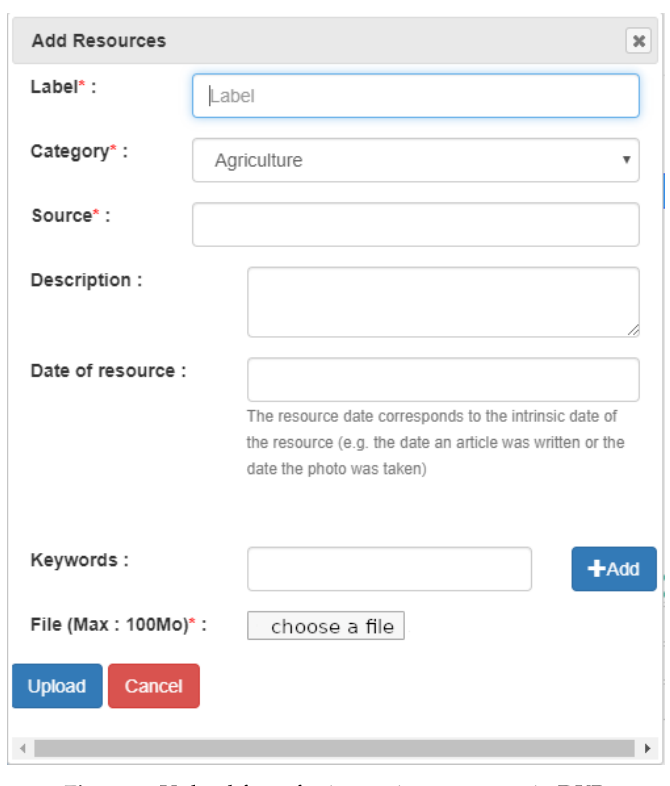
Figure 5. Upload form for importing resources in